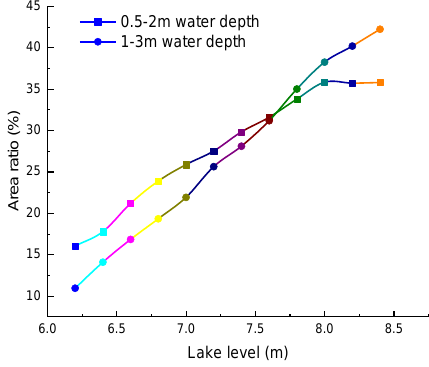
Figure 11. Area ratios of specific water depth at different lake levels.